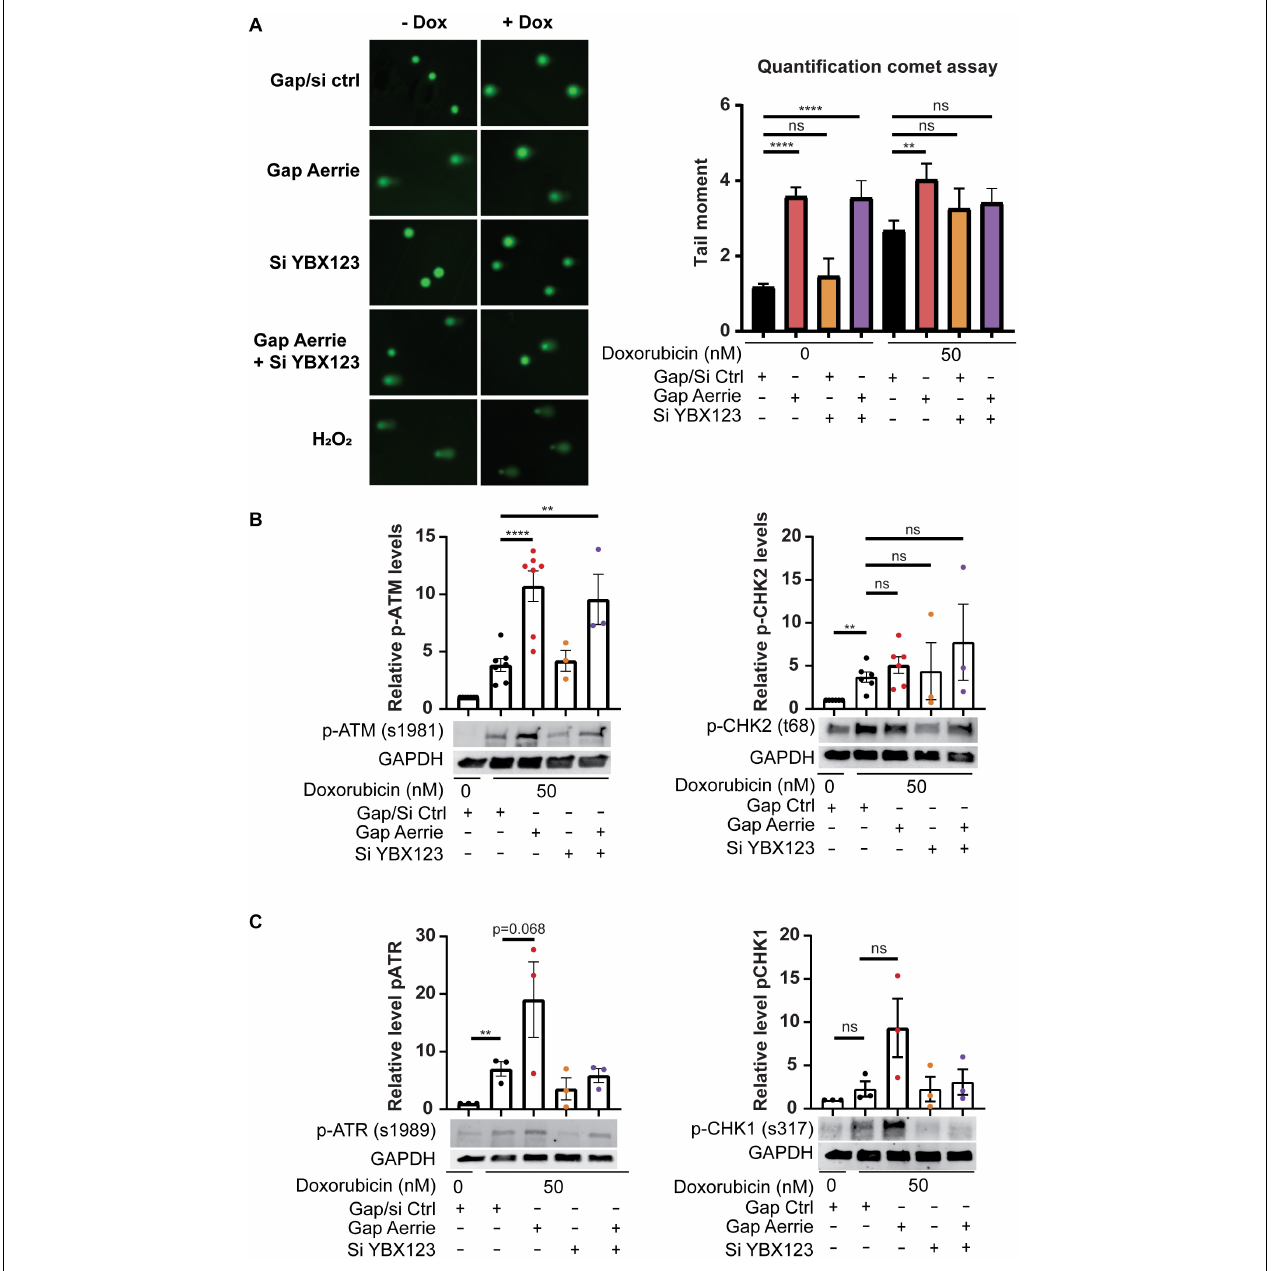
FIGURE 5 | Loss of Aerrie causes DNA damage and activation of signaling, while loss of YBX1/2/3 results in impaired DNA damage signaling. (A–C) HUVECs were treated with gapmeR (gap) targeting Aerrie, siRNA (si) targeting YBX1/2/3 or a respective control. (A) DNA damage was quantified by comet assay. HUVECs were stimulated with doxorubicin (Dox, 50 nM), embedded in low melting agarose, and stained with SYBR gold for imaging by fluorescence microscopy. Comets were quantified by CometScore ( n > 3, at least 50 comets per experiment). (B) Phosphorylation levels of activated proteins in the double-strand break repair pathway were analyzed by western blotting. Phosphorylated ATM at serine 1981 and phosphorylated CHK-2 at tyrosine 68 were analyzed of Aerrie and YBX1 depleted HUVECs ( n > 3). (C) Phosphorylation levels of activated proteins in the single-strand break repair pathway were analyzed by western blotting. Phosphorylated ATR at serine 1981 and CHK-1 at serine 317 were analyzed of Aerrie and YBX1 depleted HUVECs ( n = 3). ** p < 0.01; **** p < 0.0001; ns , not statistically